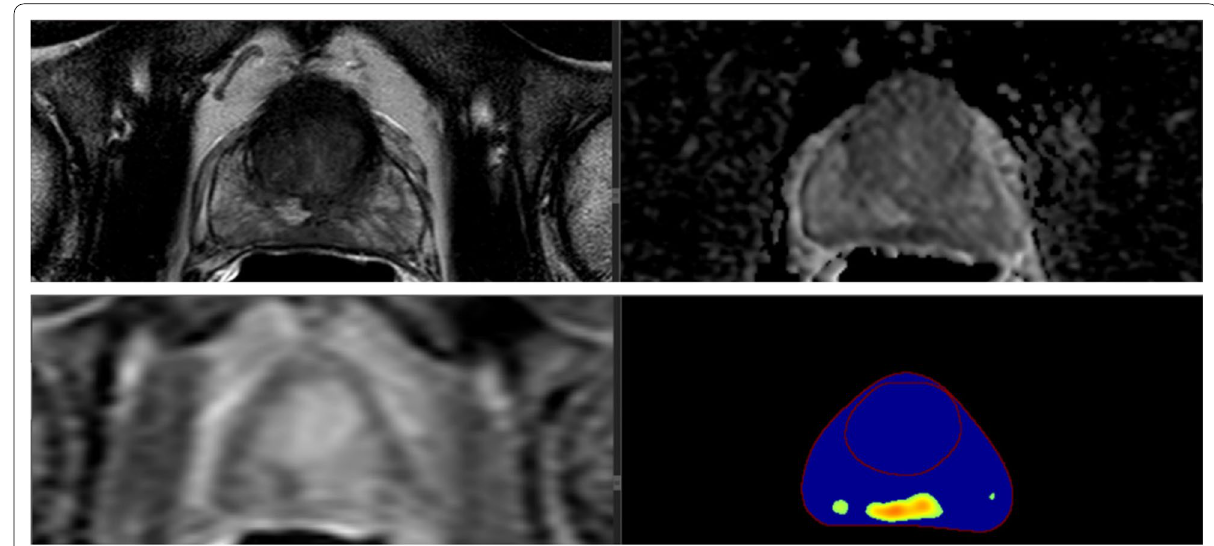
Fig. 4 Multi-channel prostate lesion computer-assisted detection model outputting probability maps and contours of prostate zones for